Question: Condense the content of this figure into a single sentence.
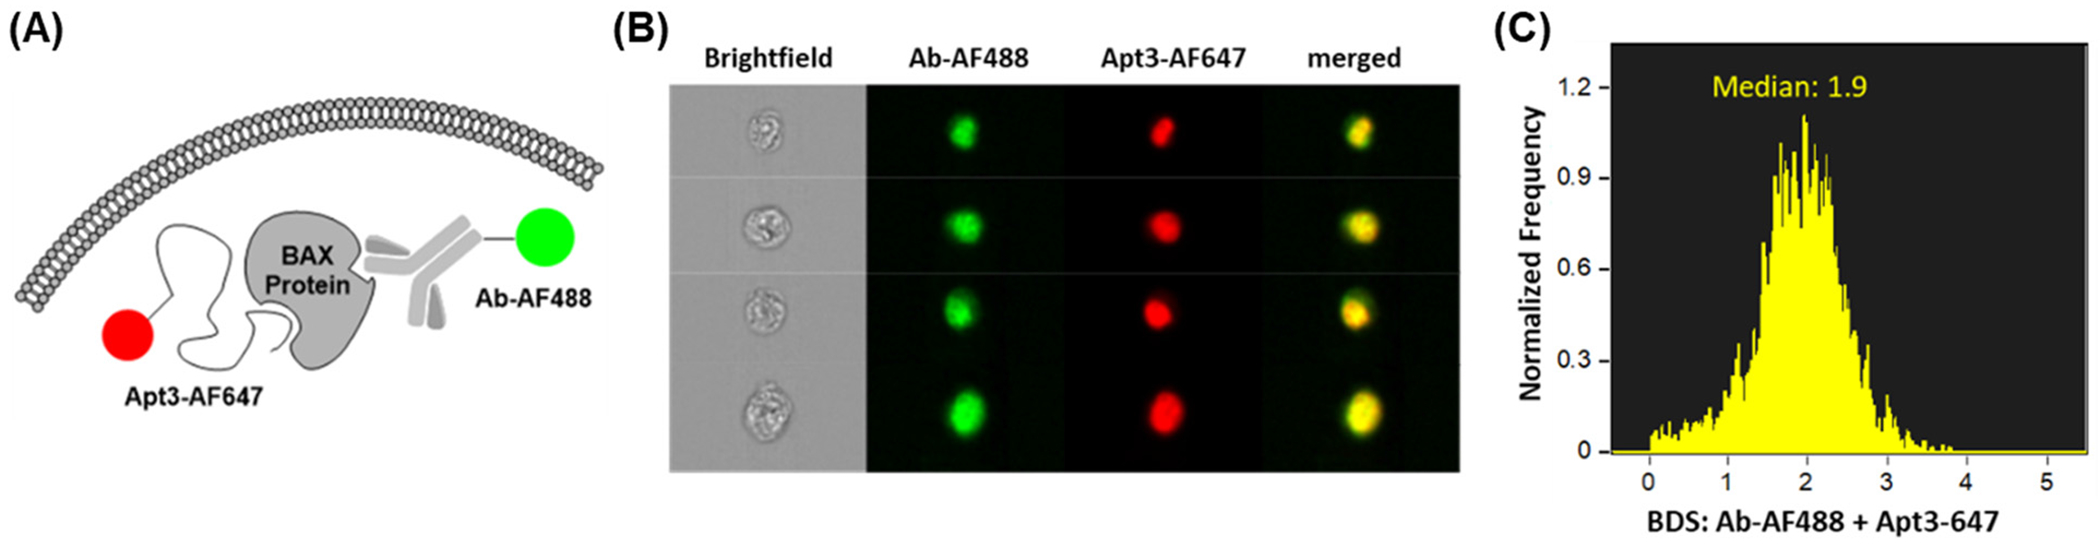
Answer: Colocalization of anti-BAX antibody and aptamer. ( A ) Design and principle of the colocalization assay: commercial antibody (Ab-AF488) and aptamer (Apt3-AF647) are designed to target different amino acid regions of intracellular BAX protein. ( B ) Representative gallery of doublepositive TK6 cells that were fixed and co-labeled with Ab-AF488 and Apt3-AF647 and acquired by imaging flow cytometry. ( C ) Bright Detail Similarity score of co-labeled double-positive TK6 cells.